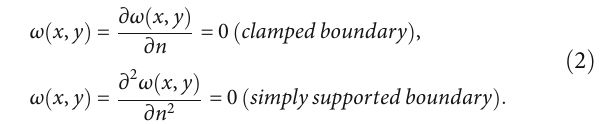
Figure 1: The plate system occupying the rectangular region Ω